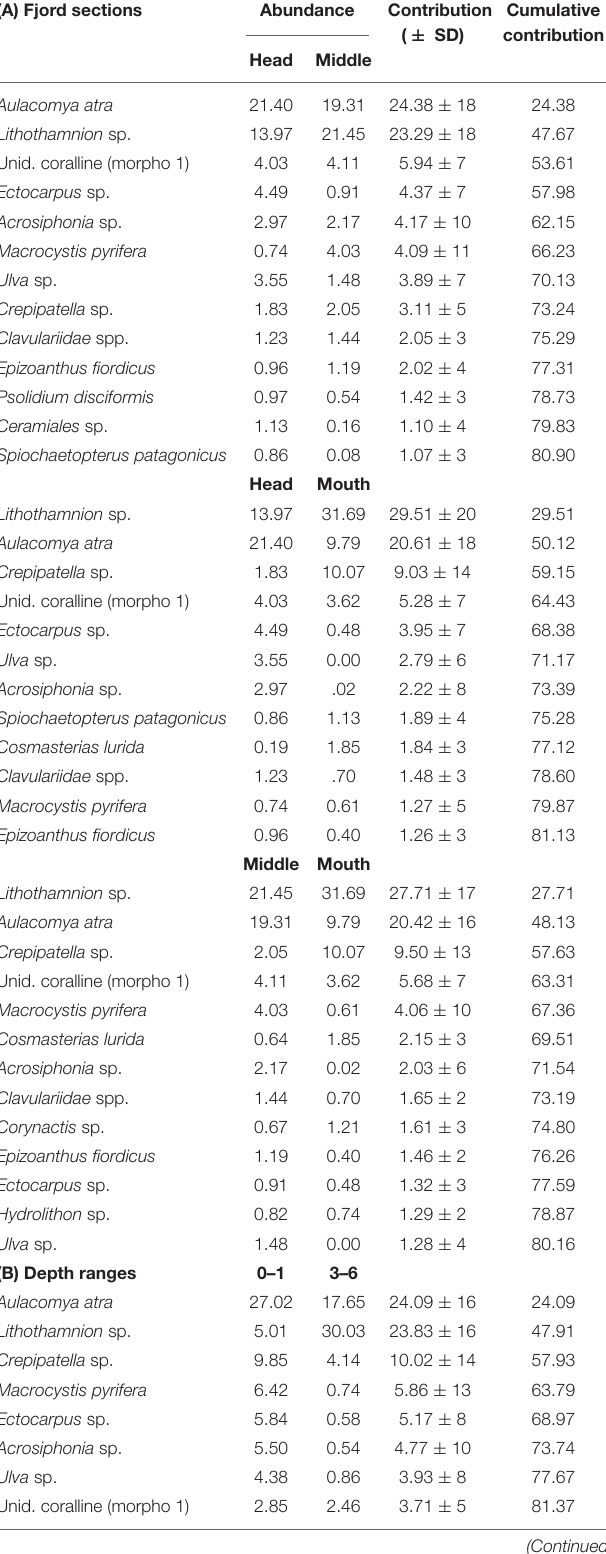
TABLE 5 | Summary of SIMPER results for sections and depth ranges of Comau fjord. (A) Fjord sections